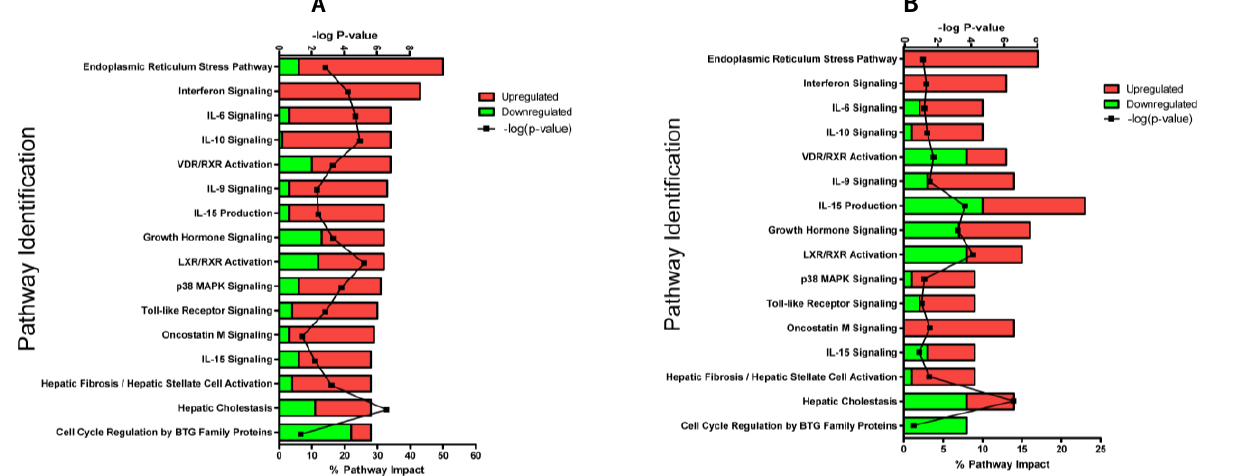
Figure 3. Results of Ingenuity Pathway Analysis for rats treated with either LPS or TNF . Ingenuity software was applied to classify the top pathways that were impacted after treatment. To account for inter-individual variability, gene expression profiles from each TNFα- or LPS-treated rat were combined in silico using Resolver software. From these combined groups, genes with |fold change| ≥ 2.0 and p 0.05 were evaluated in the pathway analysis. Pathways were separated into those perturbed by both LPS and TNFα (Panel A/B) and by those changed uniquely by each respective agent (Panel C/D). Pathway names are listed on the y-axis and percent impact is listed on the x-axis. Each bar is subdivided to indicate the relative percentage of upregulated (red) vs. downregulated (green) genes. P-values were also generated as indicated by the black line using the entire array as the background set. ( A ) Pathway analysis of the genes differentially expressed in the liver upon treatment of rats with LPS: these pathways were also changed by treatment with TNFα. The 731 overlapped genes (Figure 2) are the major component of these pathway changes. ( B ) Pathway analysis of the genes differentially expressed in the liver upon treatment of rats with TNFα: these pathways were also changed by treatment with LPS (panel A). Since these pathways were also impacted by LPS, they are listed in the same order as panel A for ease of comparison. ( C ) LPS-specific pathways were identified for the genes differentially expressed in the liver. These pathways were not perturbed by TNFα. The 3949 LPS-specific genes (Figure 2) are the major component of these pathway changes. ( D ). TNFα-specific pathways were also identified for the genes differentially expressed in the liver. These pathways were not perturbed by LPS. The 631 TNFα-specific genes (Figure 2) are the major component of these pathway changes. A